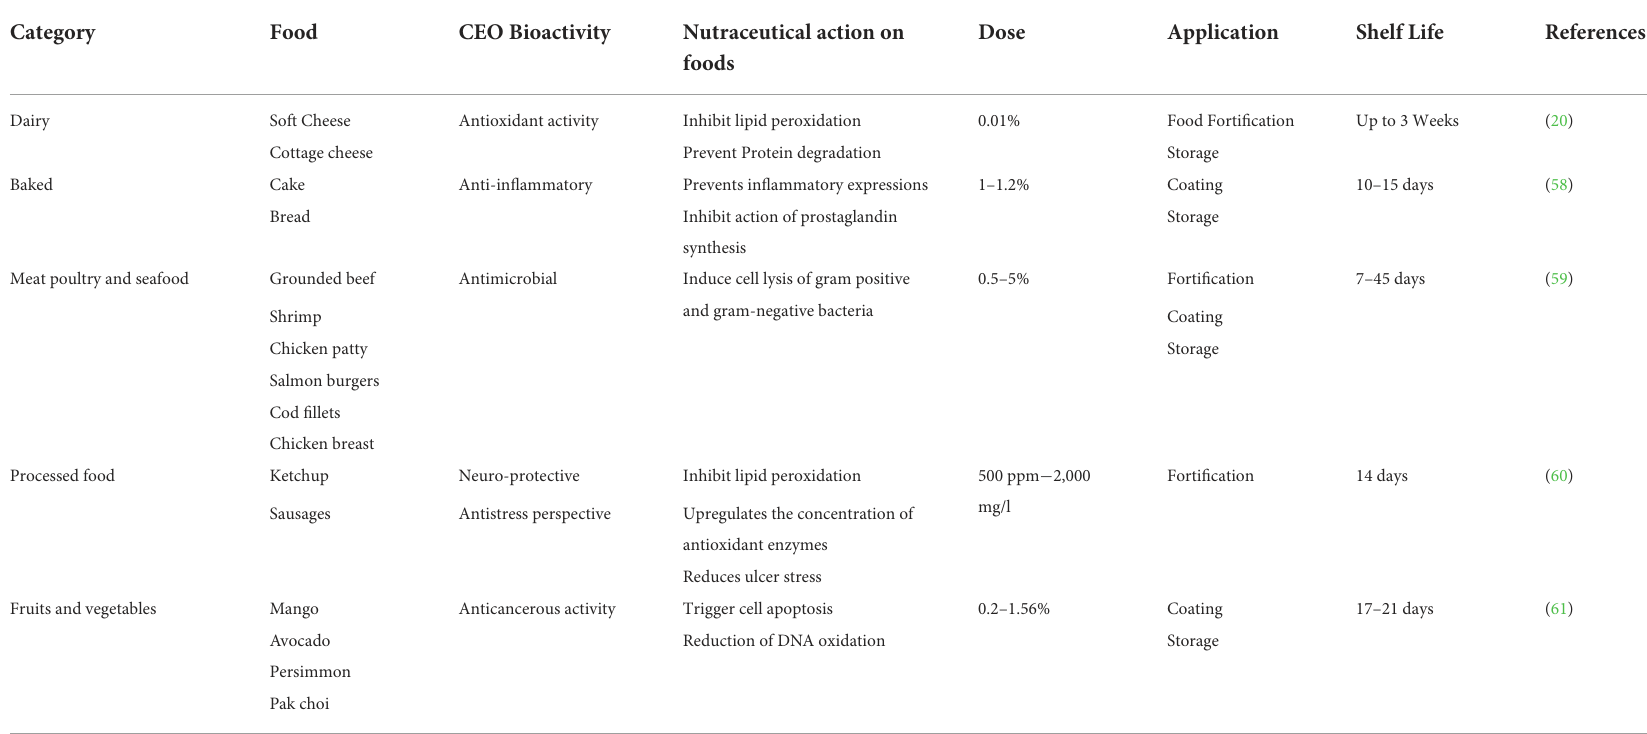
TABLE 2 Applications and nutraceutical actions of CEO in food